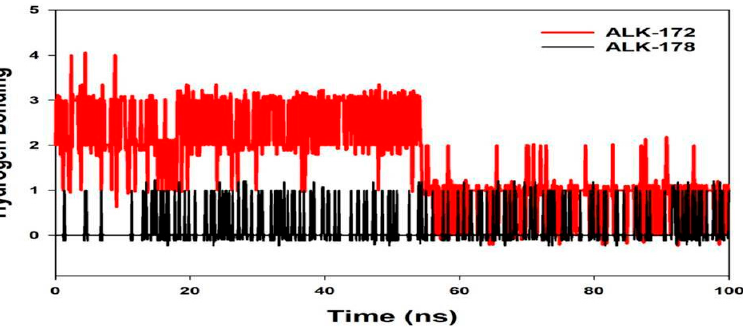
Figure 15. MD simulation trajectory analysis of Hydrogen Bonding (H-Bonds) of 172 and 178 bound with ALK at 100 ns time frame displayed H-Bond plot of 172 bound ALK (red), 178 bound ALK (black).